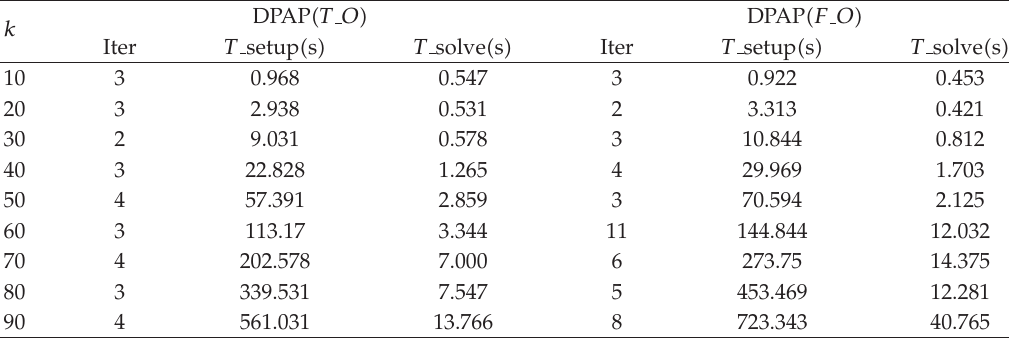
Table 4: Computational performance of Bi-CGSTAB with